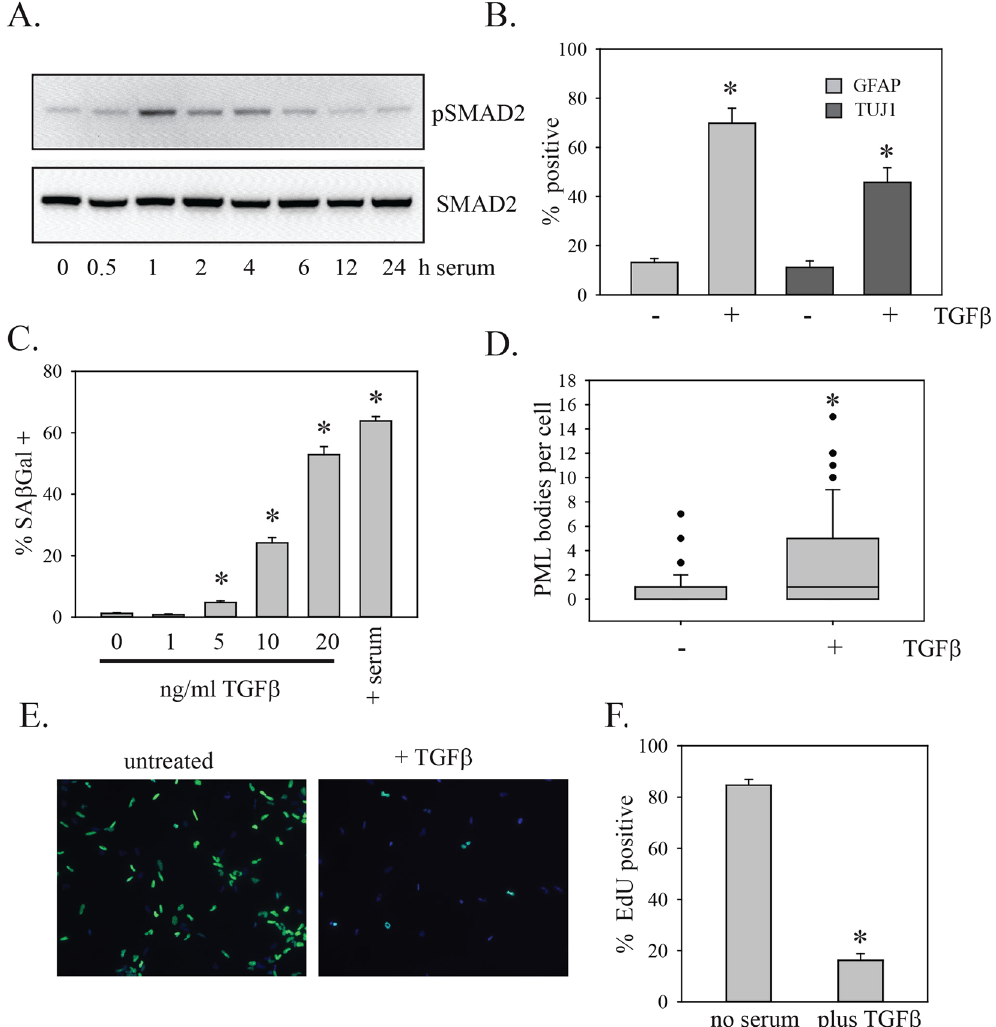
Figure 5. TGF β effects on differentiation and senescence. ( A ) PriGO8A cells were treated with media without or with 10% serum for the indicated period of time. Total cell lysates were then assayed for phosphorylated and total SMAD2 by Western blotting. ( B ) PriGO8A cells were treated with 20 ng/ml TGF β . Seven days later they were assayed for GFAP and TUJ1 expression as in Fig. 1. ( C ) PriGO8A cells were treated with the indicated concentrations of TGF β . Seven days later they were assayed for SA β gal activity as in Fig. 1. ( D ) PriGO8A cells were treated with 20 ng/ml TGF β . Seven days later they were fixed and analysed for PML bodies by immunofluorescence as in Fig. 2. ( E ) PriGO8A cells were treated as in ( B ) On day 6, they were labelled for 24 h with EdU. Cells with EdU incorporation were detected as described in Materials and Methods and nuclei were stained with DAPI. ( F ) Quantitation of EdU incorporation. Data are from five randomly chosen fields. For ( B and C ), statistical significance was determined with two-tailed t-tests. For ( D and F ), statistical significance was determined using the Mann-Whitney Rank Sum test. * Indicates p < 0.05 in comparison with the no TGF β control